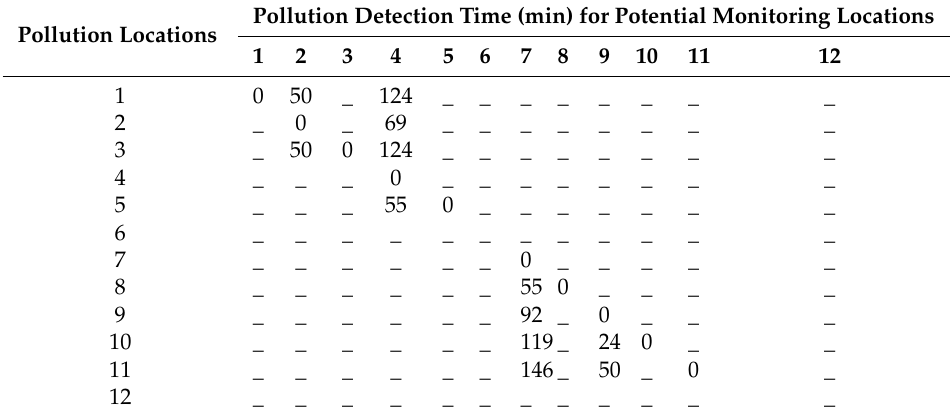
Table 4. Pollution detection time with a detection threshold of 2 mg/L. Pollution